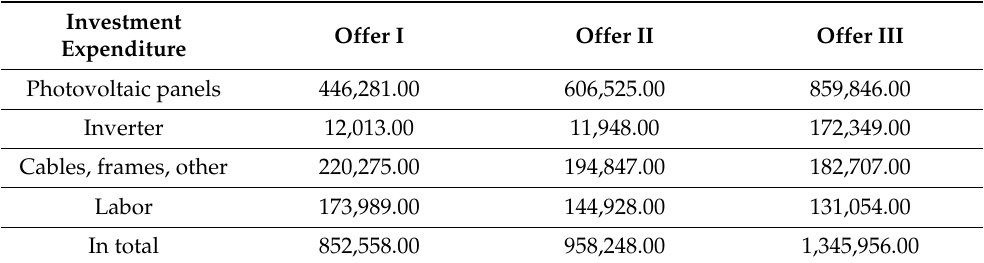
Table 11. Investment expenditure in market offers for the purchase and assembly of a photovoltaic installation. Source: designed by authors using the information obtained from the enterprise.